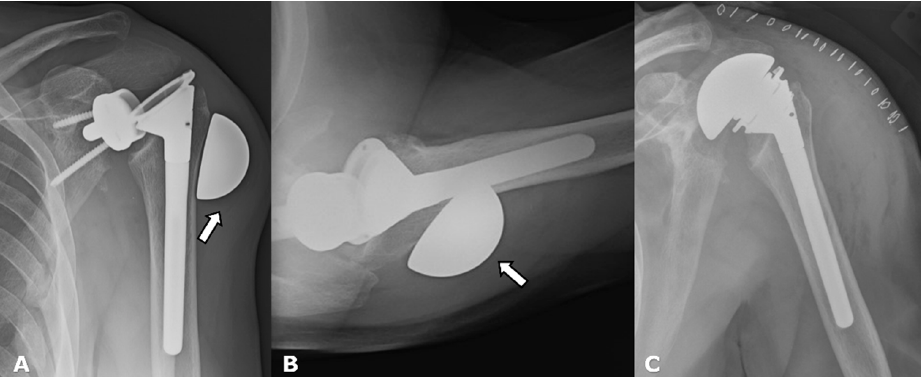
Figure 26. ( A ) Frontal and ( B ) axillary radiographs in a patient with RTSA shows dissociation of the glenosphere (arrows) from the metaglene, with displacement of the glenosphere into the posterior soft tissues. ( C ). The patient was treated via conversion to salvage HA.